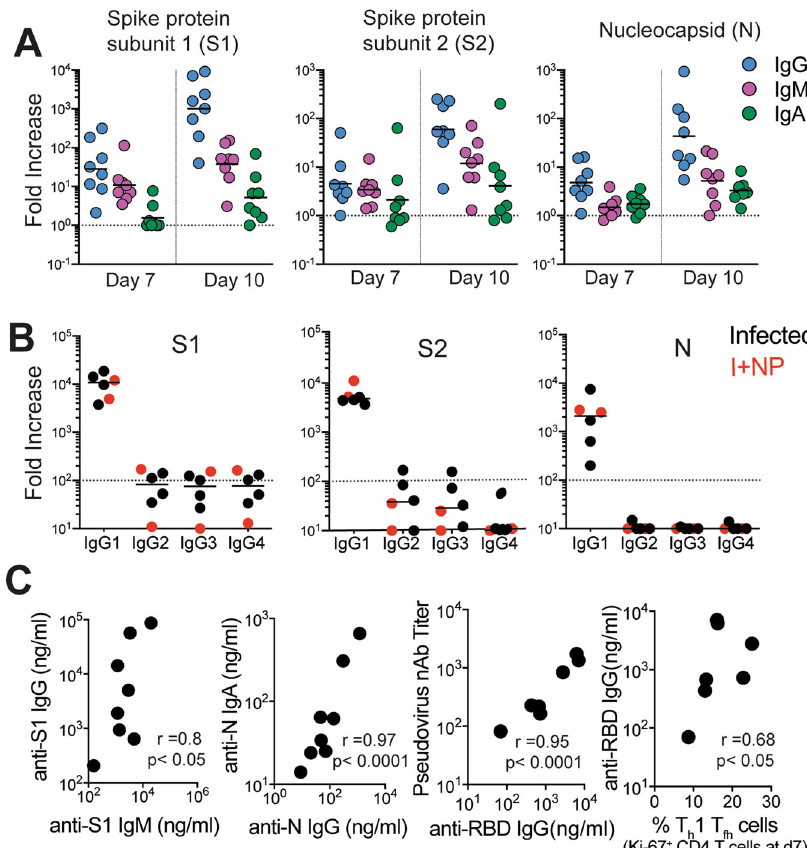
Fig. 10 IgG1 subclass and neutralizing antibodies induced following SARS-CoV-2 infection. A Fold increase in antibody responses in animals was determined by dividing post-infection concentrations by those measured on day 0 in each animal. Data shown are n = 8 animals for all time points. Horizontal line indicates median B Fold increase in IgG1, IgG2, IgG3, and IgG4 antibodies against S1, S2, and N show dominance of IgG1 subclass antibodies. Data shown are for n = 6 animals not given CP. C Correlations between day 10 levels of S1-speci fi c IgG and IgM, N-speci fi c IgA and IgG, and